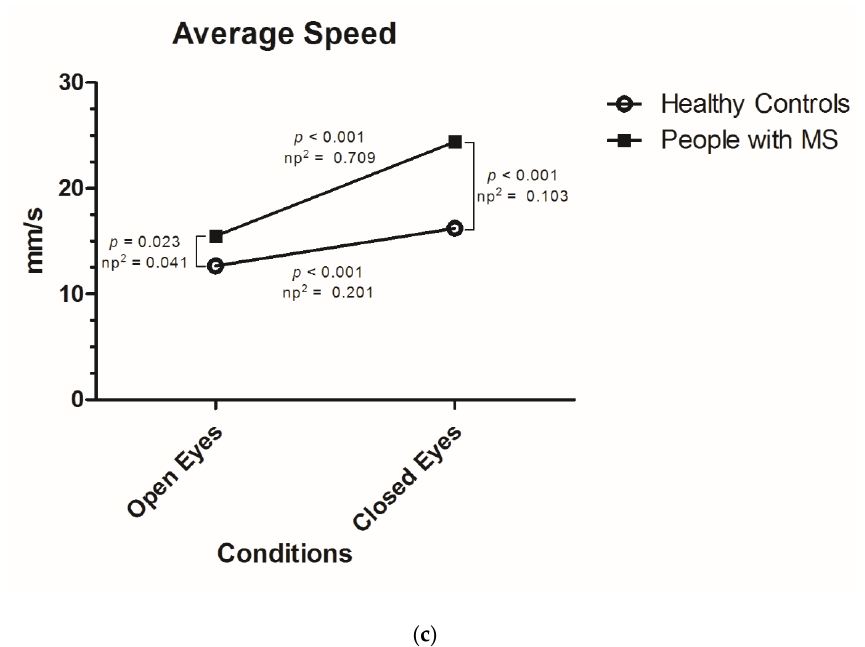
Figure 1. Graphical overview of the interaction effects and associated simple (main) effect analyses as Bonferroni-based post-hoc comparisons. Simple effect analyses revealed the degree to which one factor (vision) is differently effective at each level of another factor (multiple sclerosis (MS) diagnosis), and vice versa. In Figure ( a ) and ( c ), the interaction was significant and simple effects analyses revealed significant differences between people with MS (PwMS) and healthy controls (HC) in both conditions, as well as significant differences between the closed and open eyes performance for both groups. Higher effect sizes were seen for the vision effect in PwMS and MS diagnosis effect in closed eyes condition. In Figure ( b ), the interaction was not significant as visually indicated by almost parallel lines, but the main effect of vision was statistically significant. A simple (main) effect analyses was also carried out in ( b ) in order to assess the magnitude of the effect of vision in dependence of the level of MS diagnosis in more detail. See Table 2 for descriptive statistics in detail and Table 3 for exact p -values of the interaction effects. np 2 = Partial Eta-squared.